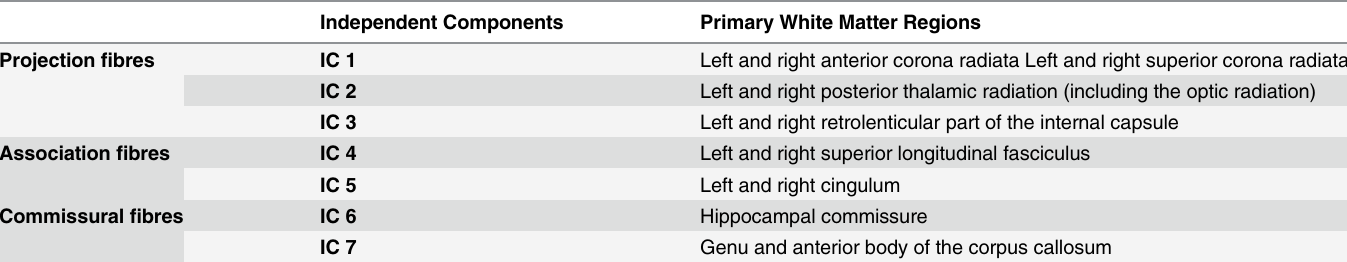
Table 1. Locations of the covariant FA changes for each IC spatial map in AD patients compared to